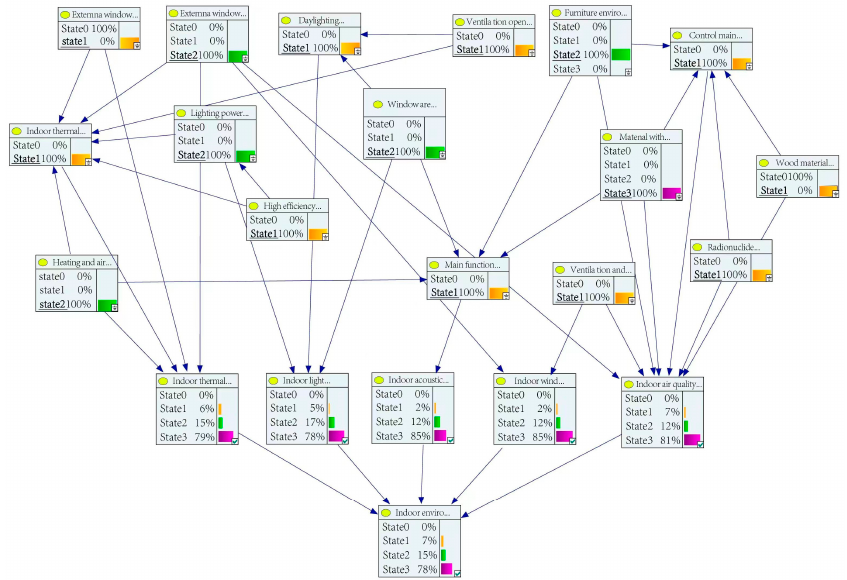
Figure 11. Bayesian network reasoning optimization diagram of indoor environmental quality assessment of a decoration project in Xuzhou.